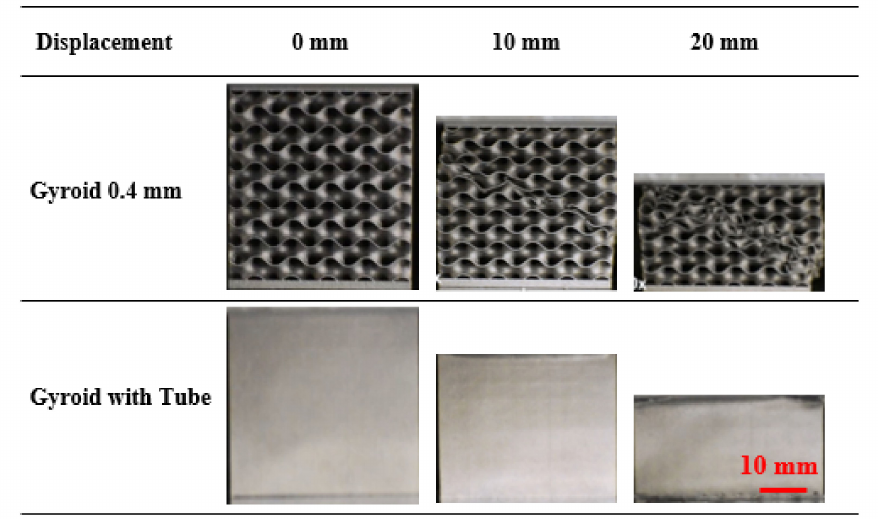
Figure 18. Gyroid TPMS structure with and without tube enclosure subjected to axial compression.